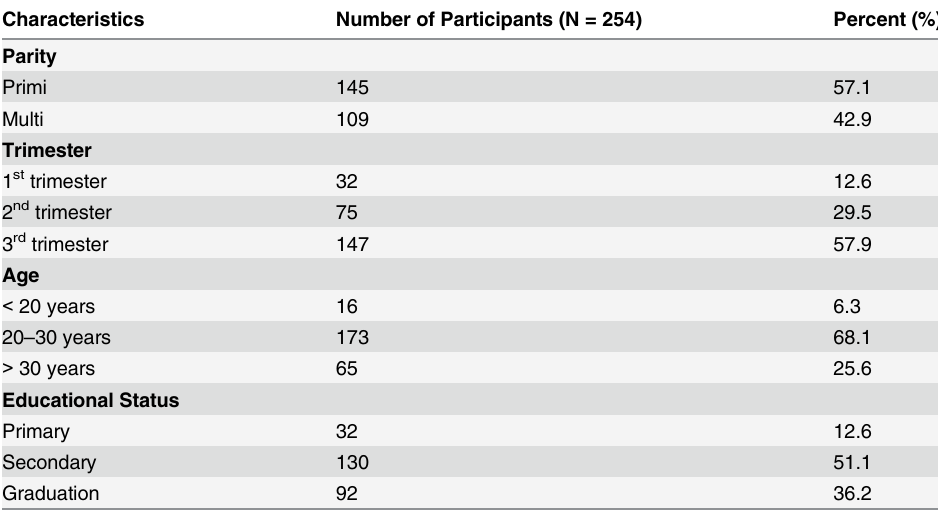
Table 1. Demographic characteristics of the population studied.